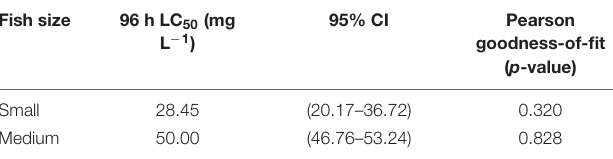
TABLE 2 | Lethal concentration for 50% of fish population (LC 50 , mg L − 1 ) when exposed for 96 h to cyanide (CN − ) and respective 95% confidence limits and Pearson goodness-of-fit in small (25.00 ± 0.03 mm total length and 0.30 ± 0.09 g weight) and medium sized (38.00 ± 0.02 mm total length and 1.12 ± 0.21 g weight) Amphiprion ocellaris .